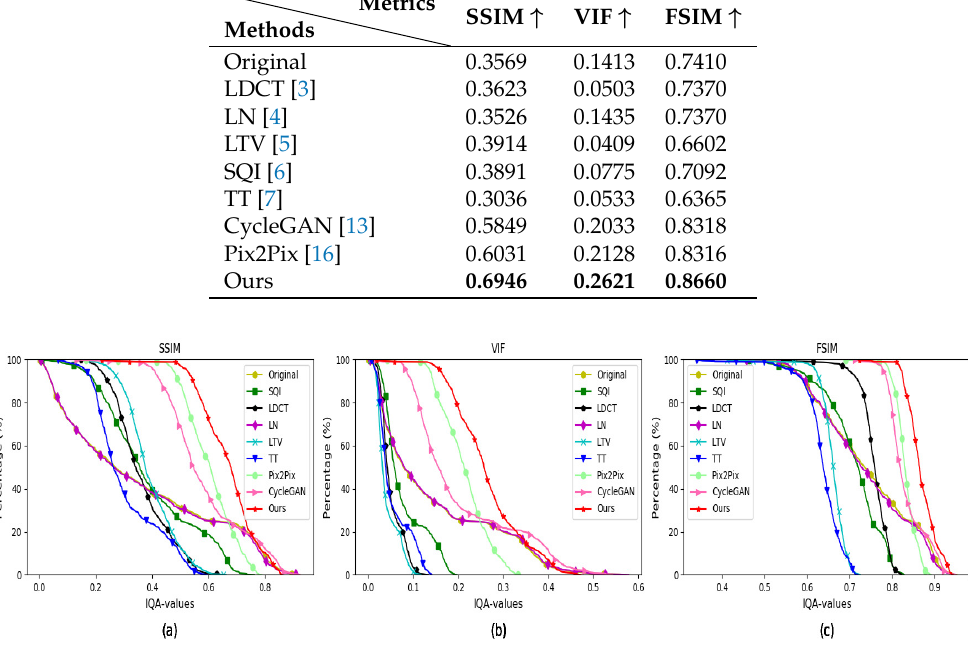
Figure 9. FR-IQA values of the face images synthesized by various algorithms on the YaleB dataset. ( a ) SSIM values of synthesized faces; ( b ) VIF values of synthesized faces; ( c ) FSIM values of